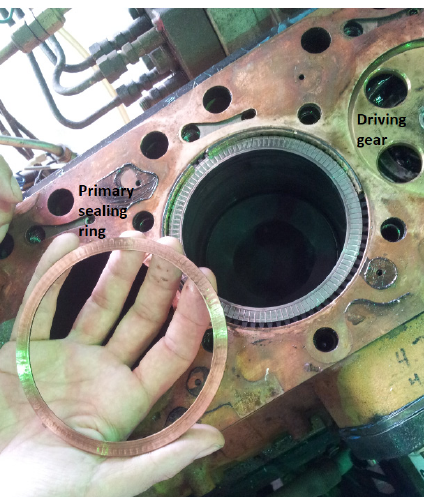
Figure A1. Detail of the rotating liner during a tear down. The active cylinder is number 2. The driving gear is identical in size to the gear on the rotating liner, proving that there is sufficient space for all cylinders to be converted. Lubricant flows under the rotating liner flange, through the radial passages of the rotating liner face, and back to the sump.